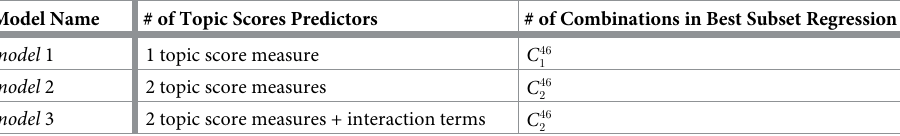
Table 4. Model settings of the empirical